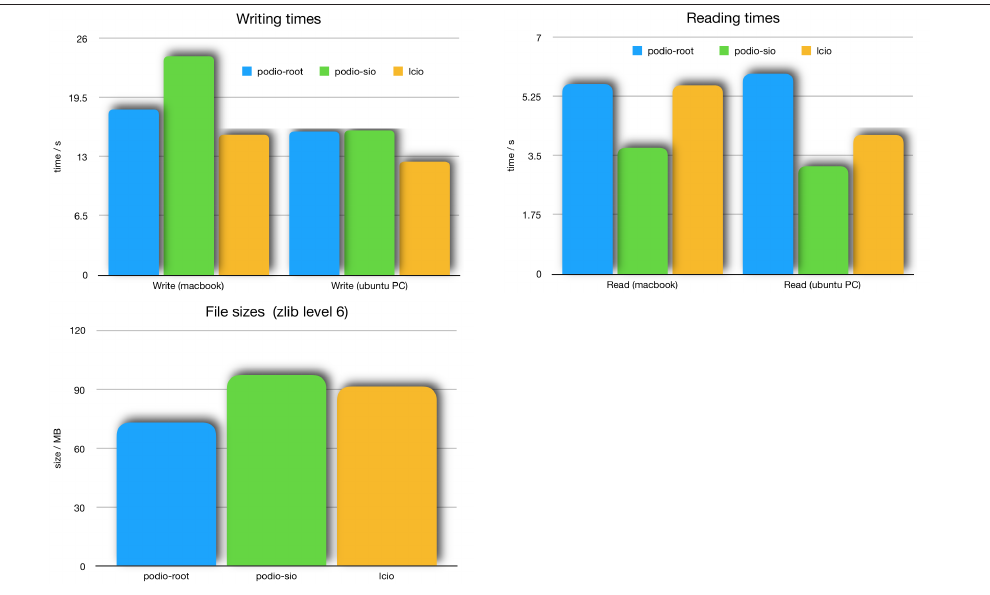
Figure 3. Performance comparison for writing, reading and the file size for the two PODIO I / O layer implementations based on ROOT and SIO and the original LCIO for comparison. The files used, contain 17061 generated t ¯ t -events that are written and read